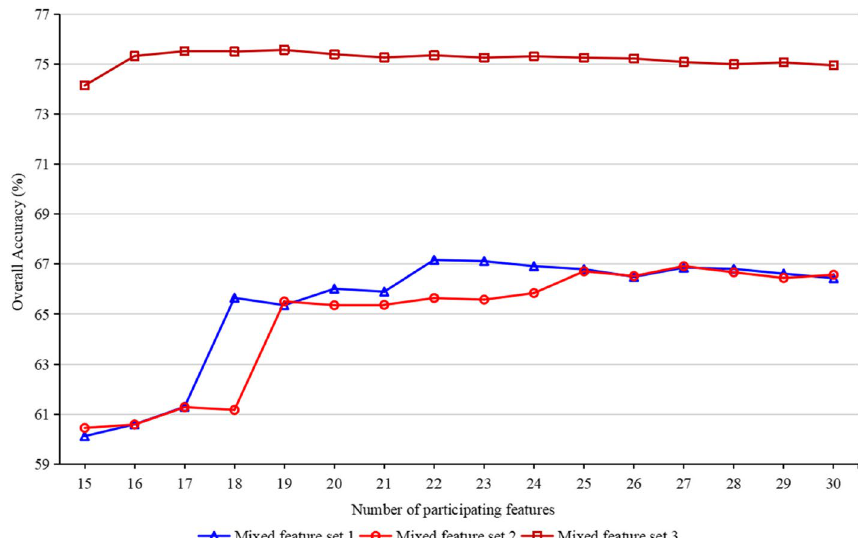
Fig. 3 Relationship between the number of participating important features and the overall accuracy of tree species identification. According to the importance values of different features in Table 4, the classification results of all the top 15–30 features were selected for